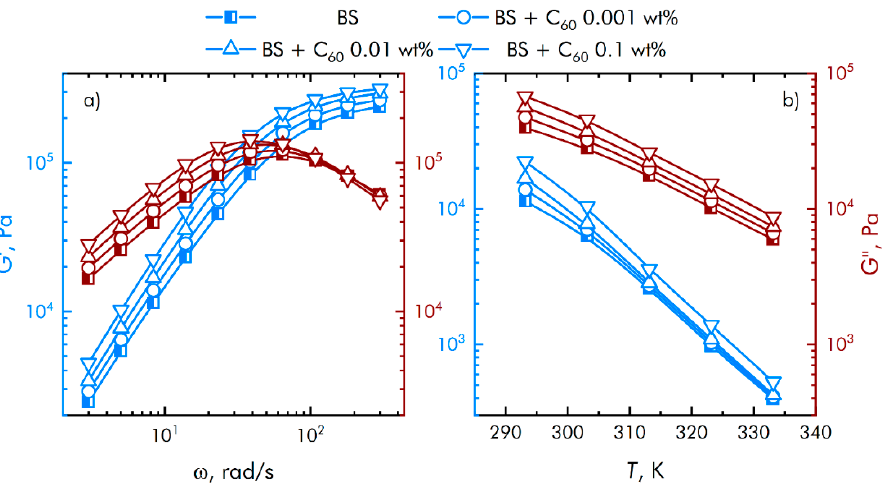
Figure 6. Influence of composite material based on boroxiloxane and fullerenes on the mechanical spectra; storage modulus—blue symbol, loss modulus—red symbol. Influence of the angular velocity of movement of the measuring surfaces on the mechanical properties of nanocomposites ( a ). Effect of temperature on the mechanical properties of nanocomposites ( b